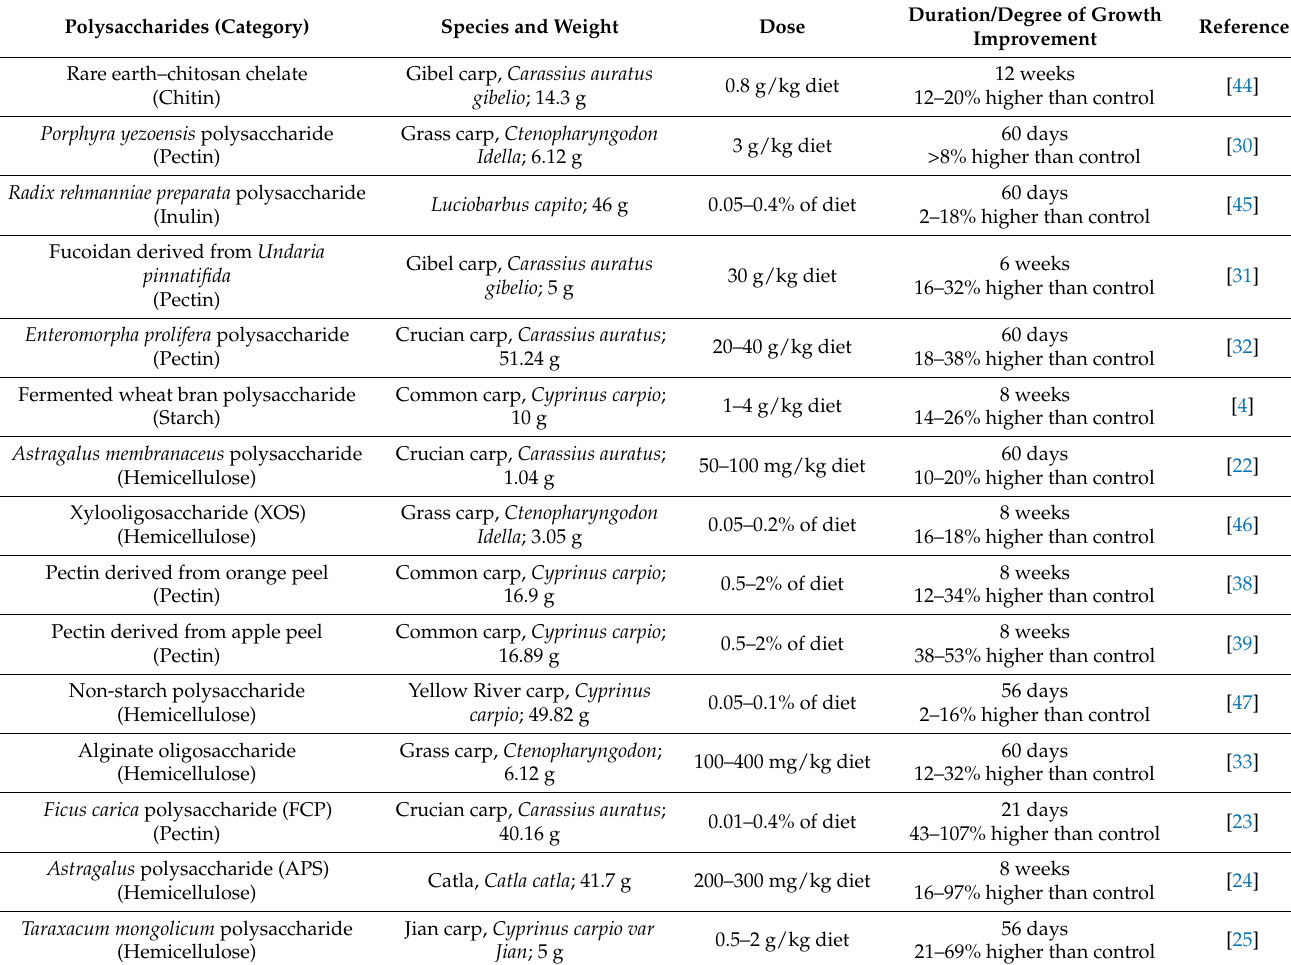
Table 1. Polysaccharides in improving growth performance of carp